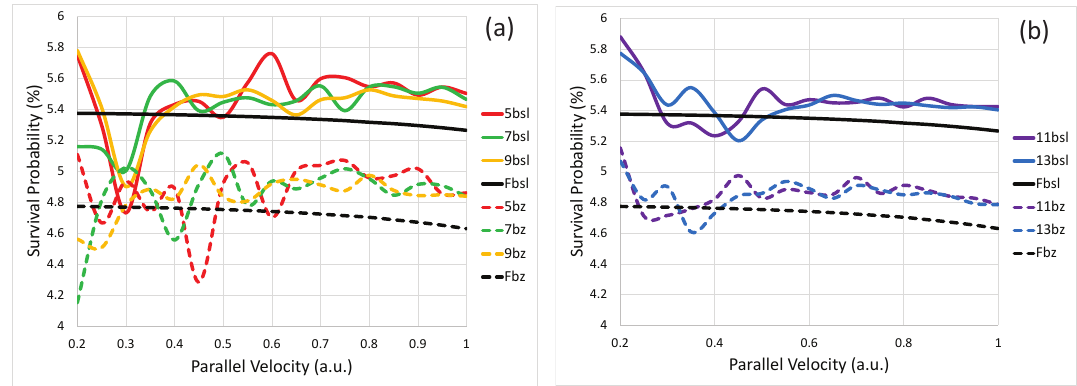
Figure 4. H − survival probability for one atomic-layer high vicinally stepped Cu(111) as a function of ion parallel velocity ( v par ) as H − approaches the center of a terrace for the BZ trajectory (solid line) and the BSL trajectory (dashed line) for inter-step distance ( d ) of 5, 7, and 9 lattice spacings ( a ) and for d of 11 and 13 lattice spacings ( b ).